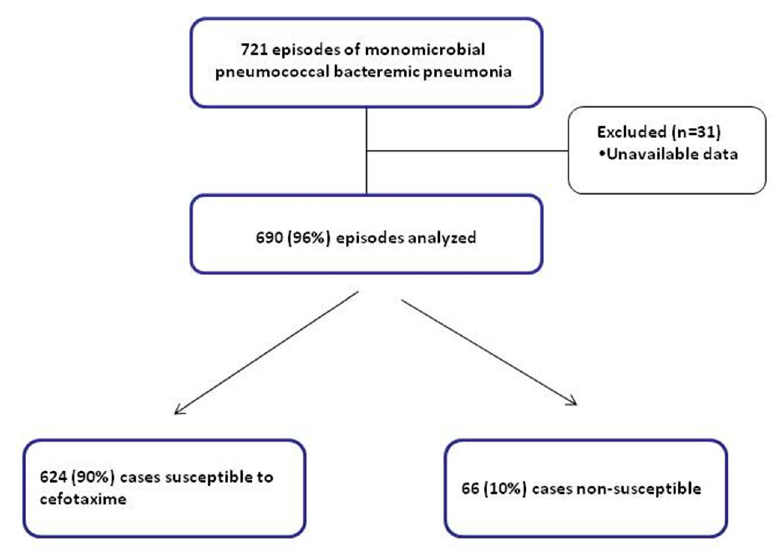
Figure 1. Flow diagram of population selection.